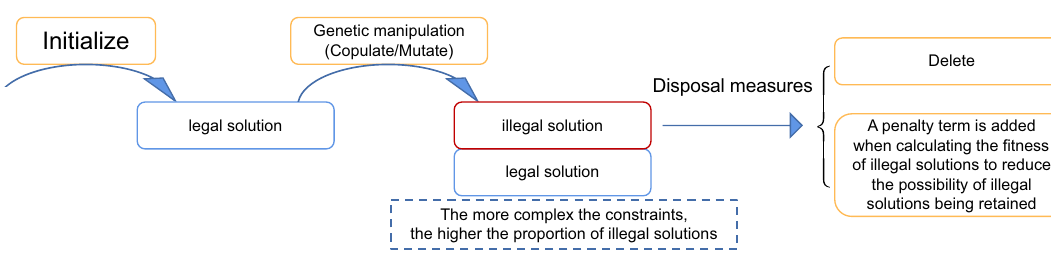
Figure 13. Flowchart of innovative genetic algorithm with real number encoding.